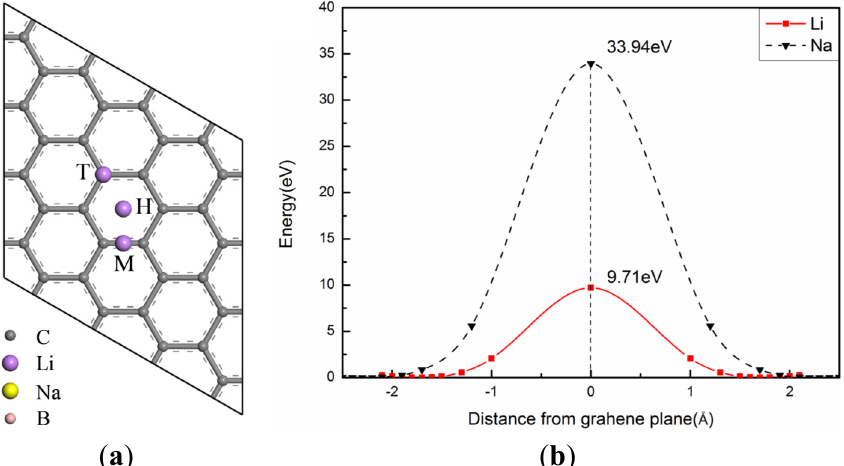
Figure 1. ( a ) Top view of 4 × 4 pristine graphene supercell with ion adsorption on three symmetrically non-equivalent sites (H, T, M); ( b ) Diffusion barriers for Li and Na to penetrate the pristine graphene via the center of the carbon hexagon.